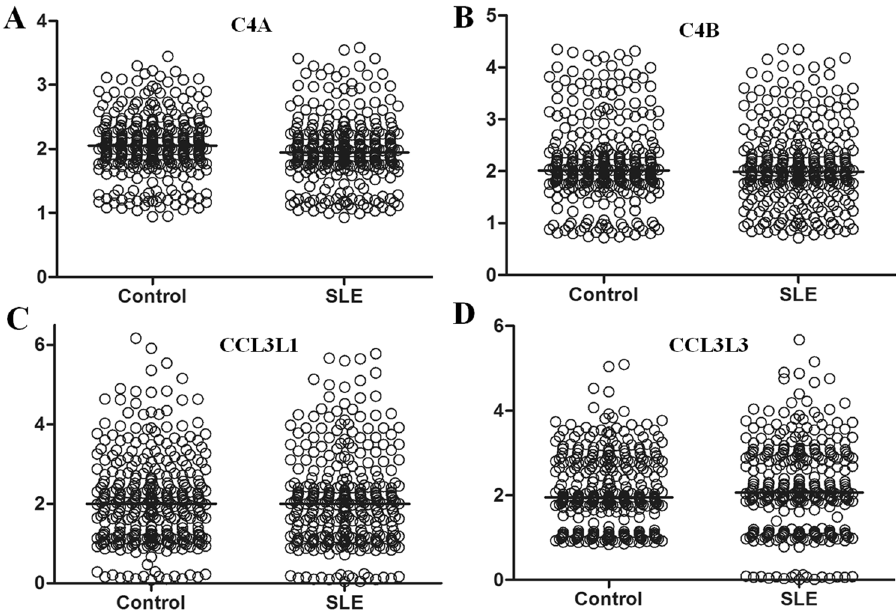
Figure 4. Difference in CNs between the controls and SLE patients in genes showing relatively high CNV. ( A ) C4A ( P = 0.0049). ( B ) C4B ( P = 0.3797). ( C ) CCL3L1 ( P = 0.7441). ( D ) CCL3L3 ( P = 0.1704). Median CN values are marked by horizontal